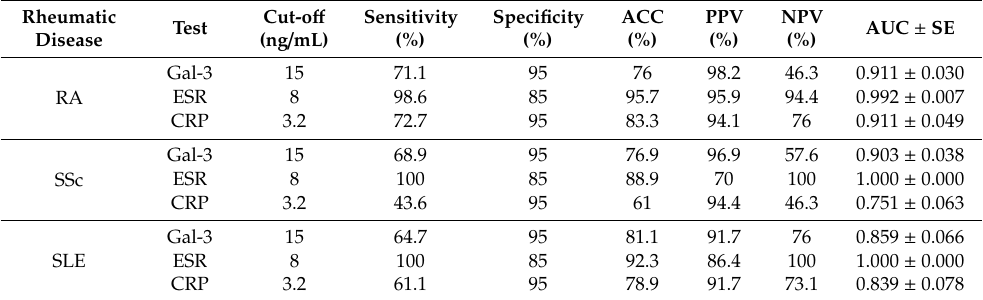
Table 2. Diagnostic power of galectin-3, ESR, and CRP in rheumatic diseases Rheumatic